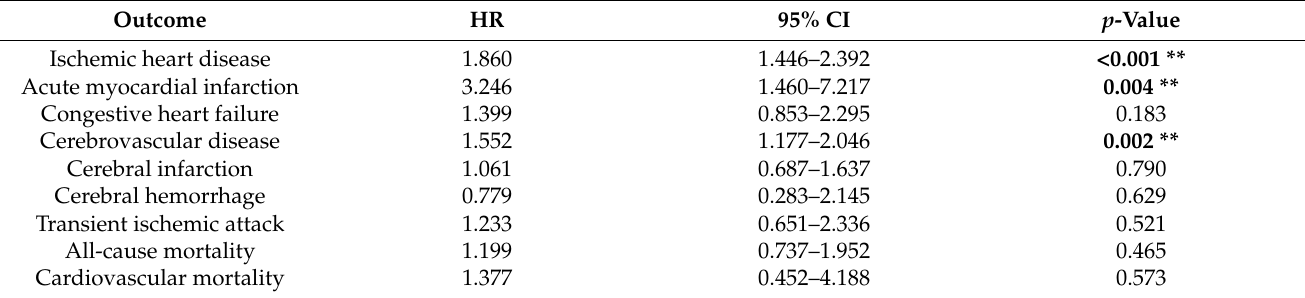
Table 2. Multivariate Cox proportional HRs for cardiovascular outcomes in gout